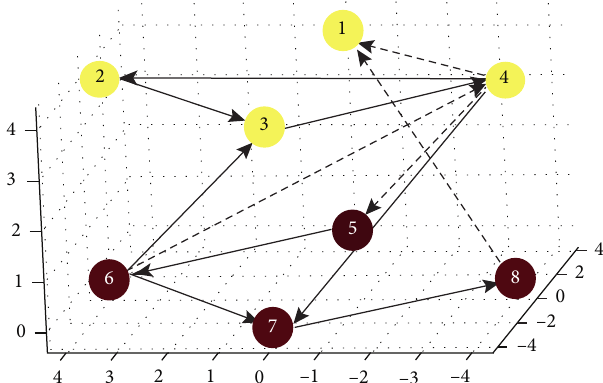
Figure 3: Under a directed graph, the multiagent system of eight